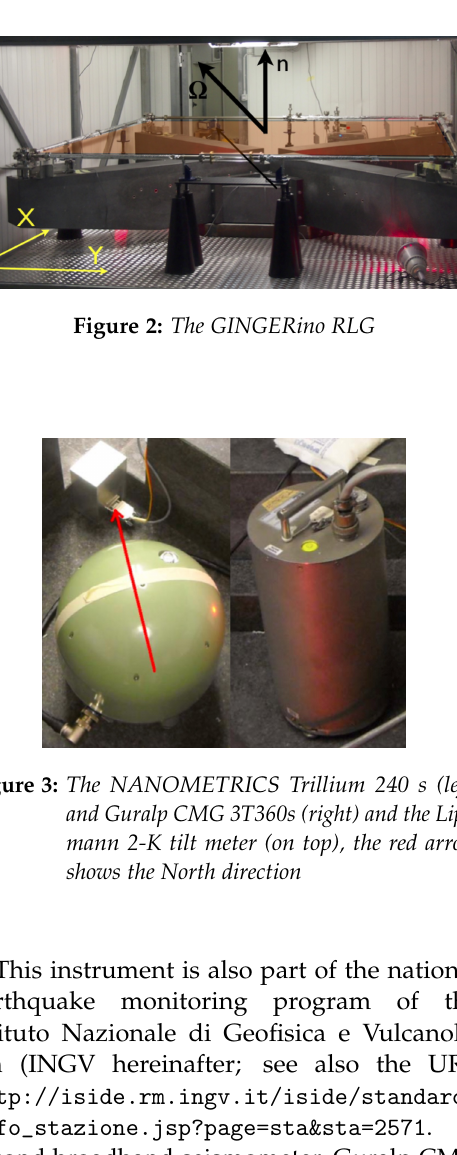
3T–360s (Fig. 3) is placed in the central block for data redundancy. A Lippmann 2-K digital tilt-meter with a resolution better then